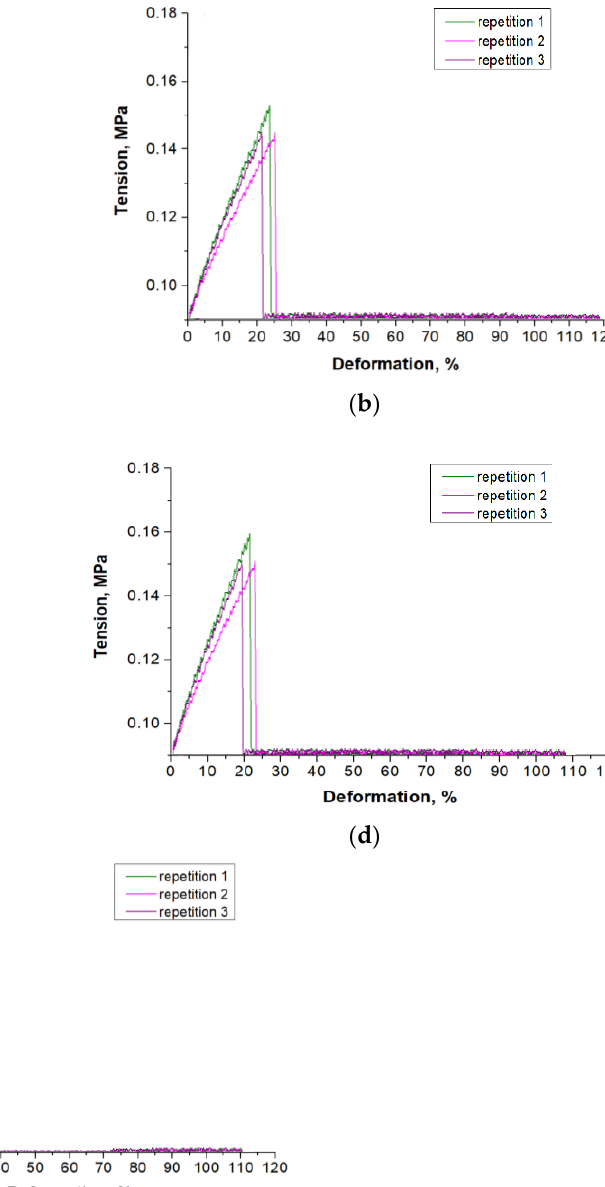
Figure 9. Results of mechanical studies of hydrogels showing their percentage elongation ( a ) and the tensile strength ( b ).